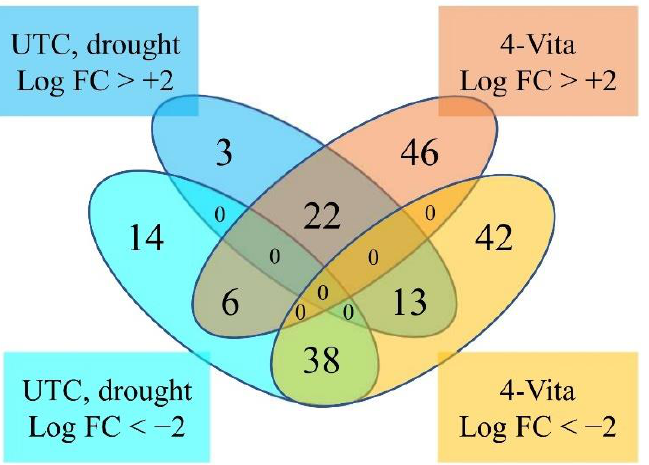
Figure 6. Venn diagram showing up- and downaccumulated metabolites under either well-watered or drought conditions, following application of 4-Vita to the tomato.